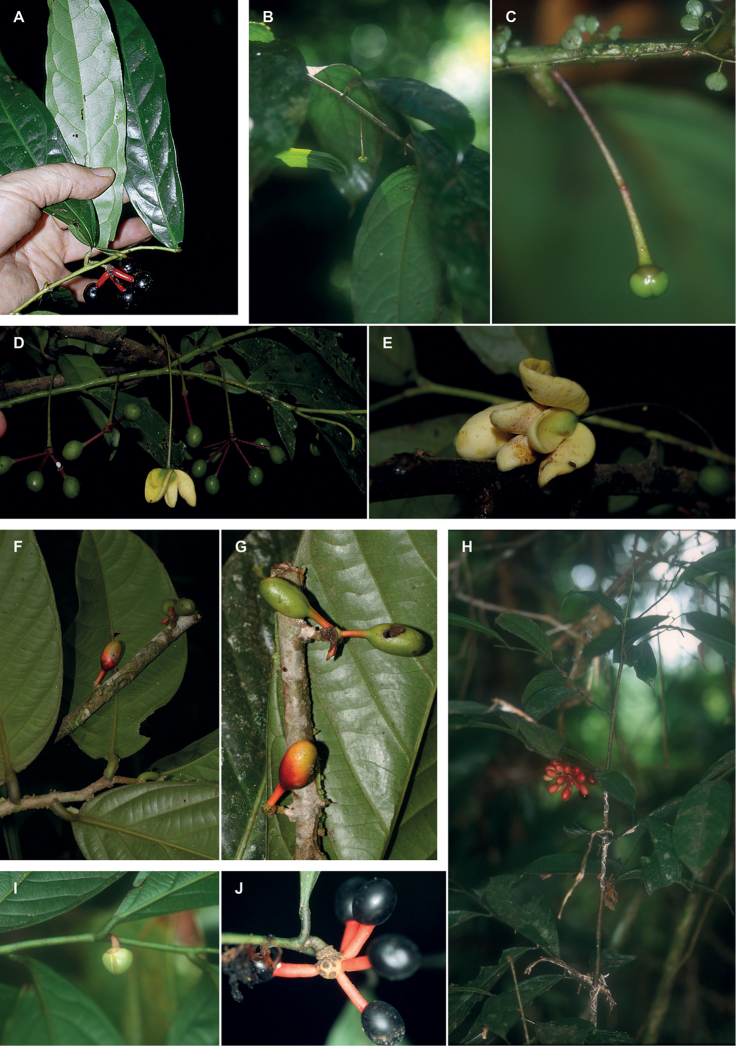
aCremastospermapanamense Maas. Fruiting specimen (photo: Robin Foster) b–eC.pendulum (Ruiz & Pav.) R.E.Fr. b habit c flower bud (Pirie et al. 33; photos MDP) d flowering and fruiting branch e flower (Vásquez et al. 34206, photos Rodolfo Vásquez) f, gC.westrae Pirie fruiting specimen (photos Robin Foster) h–jC.yamayakatense Pirie h habit, fruiting specimen (Pirie et al. 57) i flower bud (Pirie et al. 58) j mature fruit (Pirie et al. 60; photos MDP).